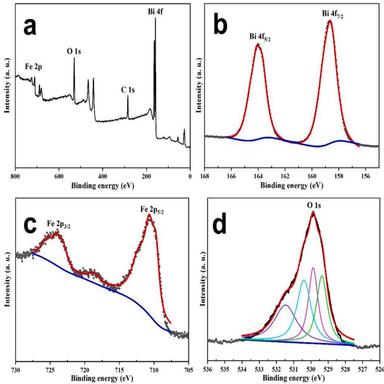
XPS of SM-BFO: (a) survey spectrum, The high-resolution (b) Bi 4f, (c) Fe 2p and (d) O 1s.